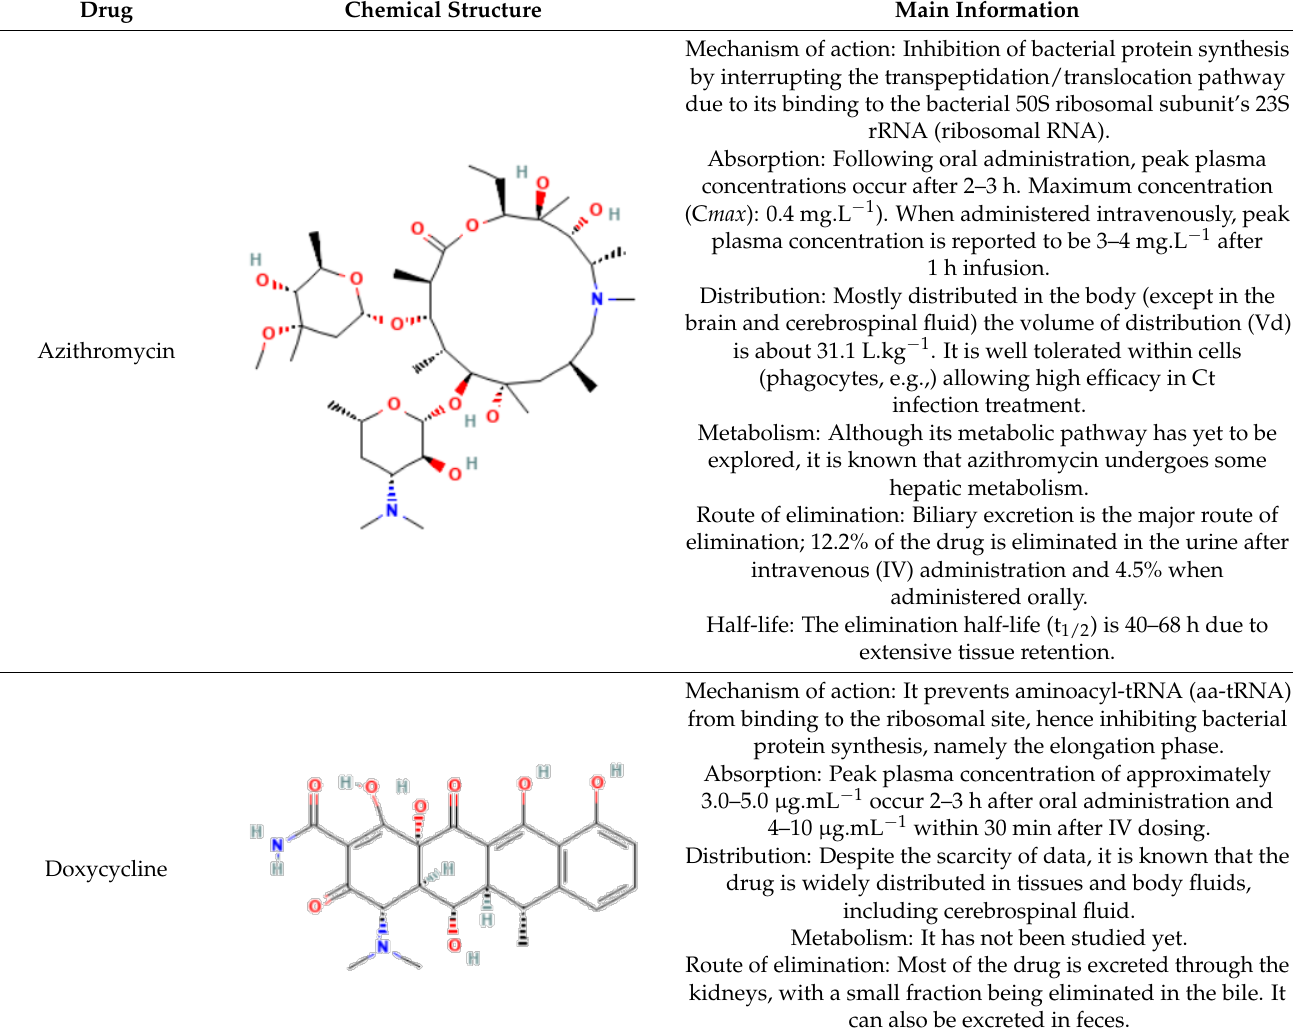
Table 2. ADME profile, mechanism of action, and chemical structure of the most common drugs used in the Ct infection treatment [45 – 52].